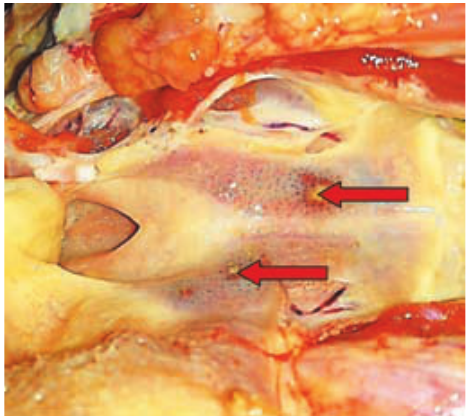
Fig. 3. Soft palate tonsil showing congestion and multi-focal ulcerative lesions (arrows)